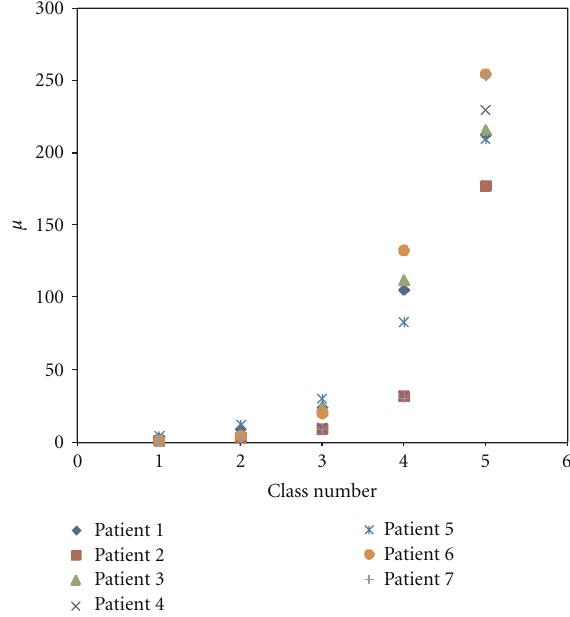
Figure 9: Clinical PET data set 2: the μ values for classes one to